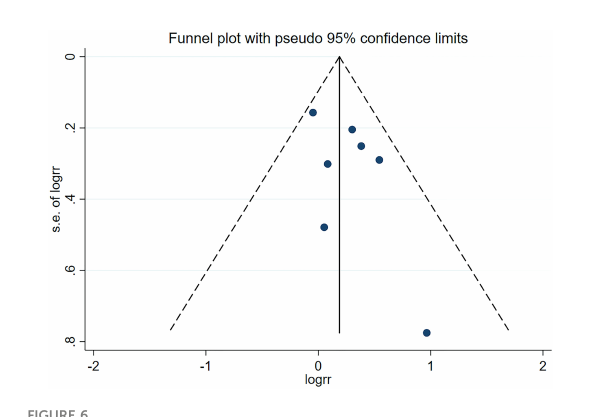
FIGURE 6 Funnel plot of positive surgical margins for publication